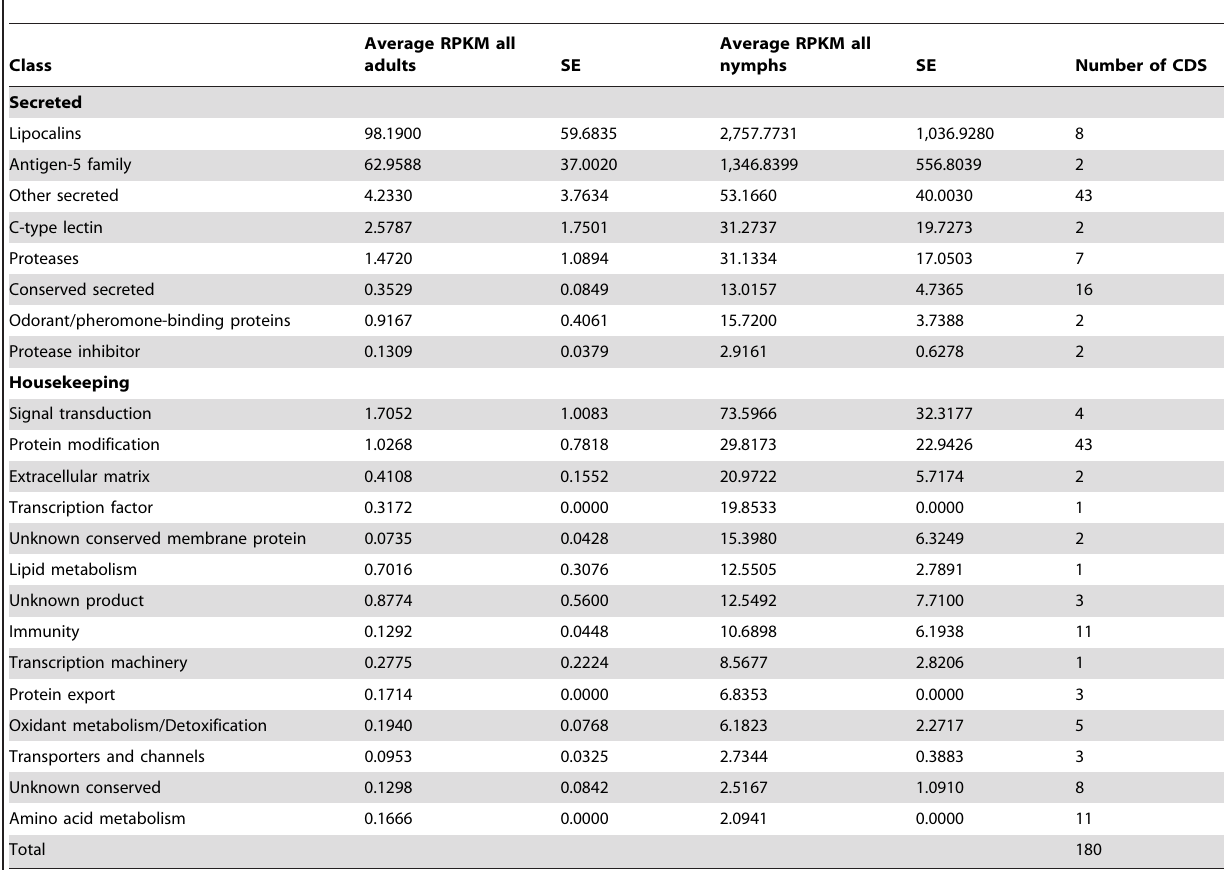
Table 5. Classification of coding sequences at least 10 6 overexpressed in nymphal libraries when compared to adult